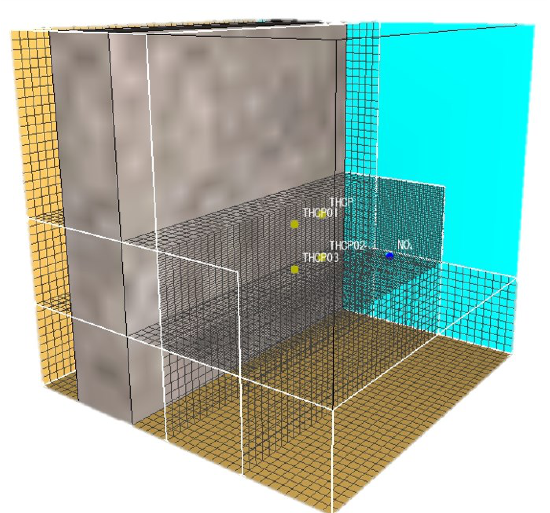
Fig. 3. The inner mesh bases and devices of the model